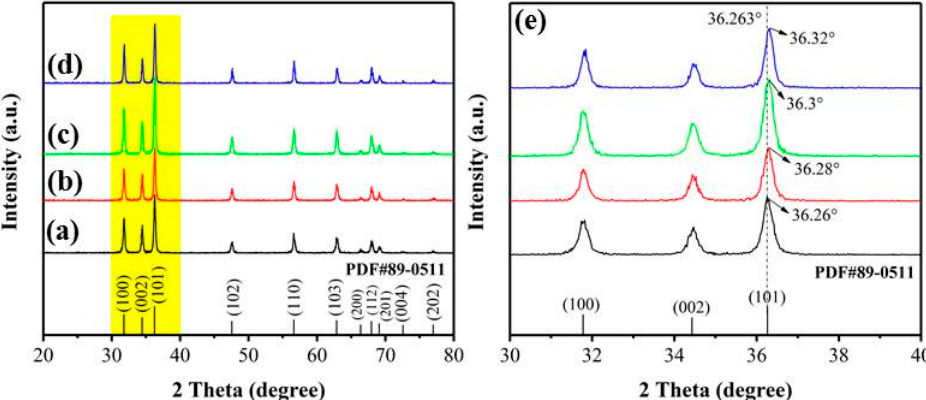
Figure 2. XRD patterns: ( a ) ZnO, ( b ) Co 3 O 4 / ZnO-1, ( c ) Co 3 O 4 / ZnO-2, and ( d ) Co 3 O 4 / ZnO-3; ( e ) the enlarged view of the shaded portion of yellow in ( a – d ).